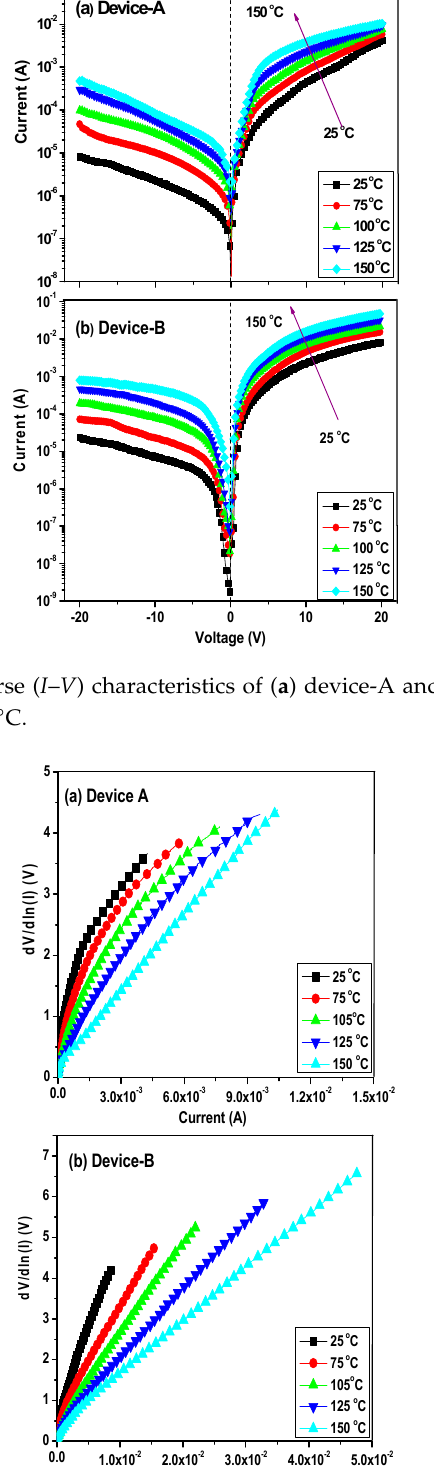
Figure 6. Plots of d V /dln( I ) versus I for ( a ) device-A and ( b ) device-B tested in the temperature range of 25 to 150 °C.